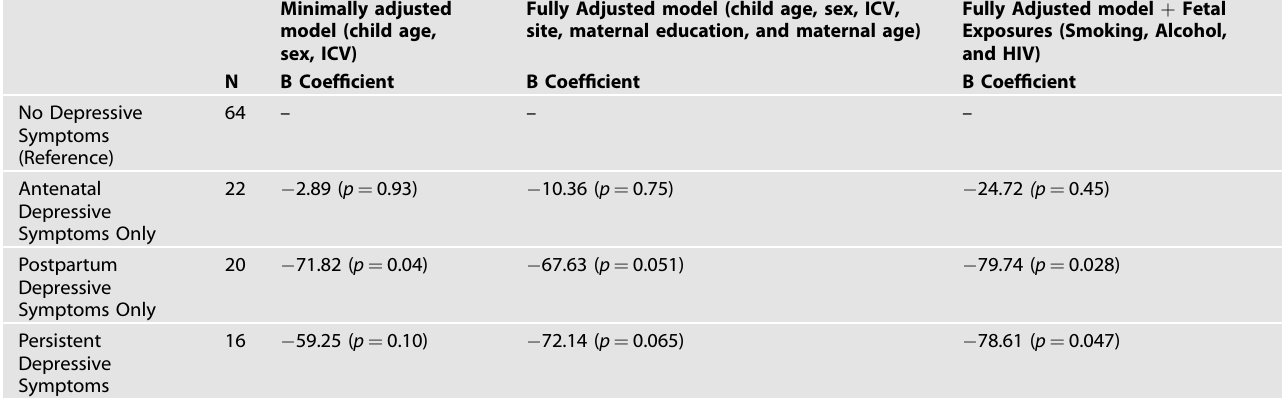
Table 4. Associations between persistent depressive symptoms across pregnancy and postpartum and amygdala volume.